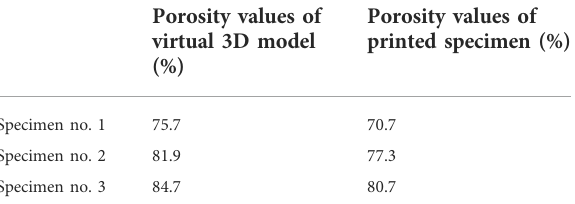
The curves had a breakpoint at 73% – 74% porosity, after TABLE 2 Porosity values. which a steep increase in the equivalent stress levels was Porosity values of Porosity values of noticeable. The reason for this was the transition from the virtual 3D model printed specimen (%) close-cell to the open-cell structure at the porosity of 73%. (%) This phenomenon is shown in Figure 7: the model remained a closed-cell lattice until 14.1 mm cut-out sphere diameter Specimen no. (Figure 7A); with 14.2 mm cut-out sphere diameter, the walls separating each pore were punctured and the model became an open-cell structure (Figure 7B).